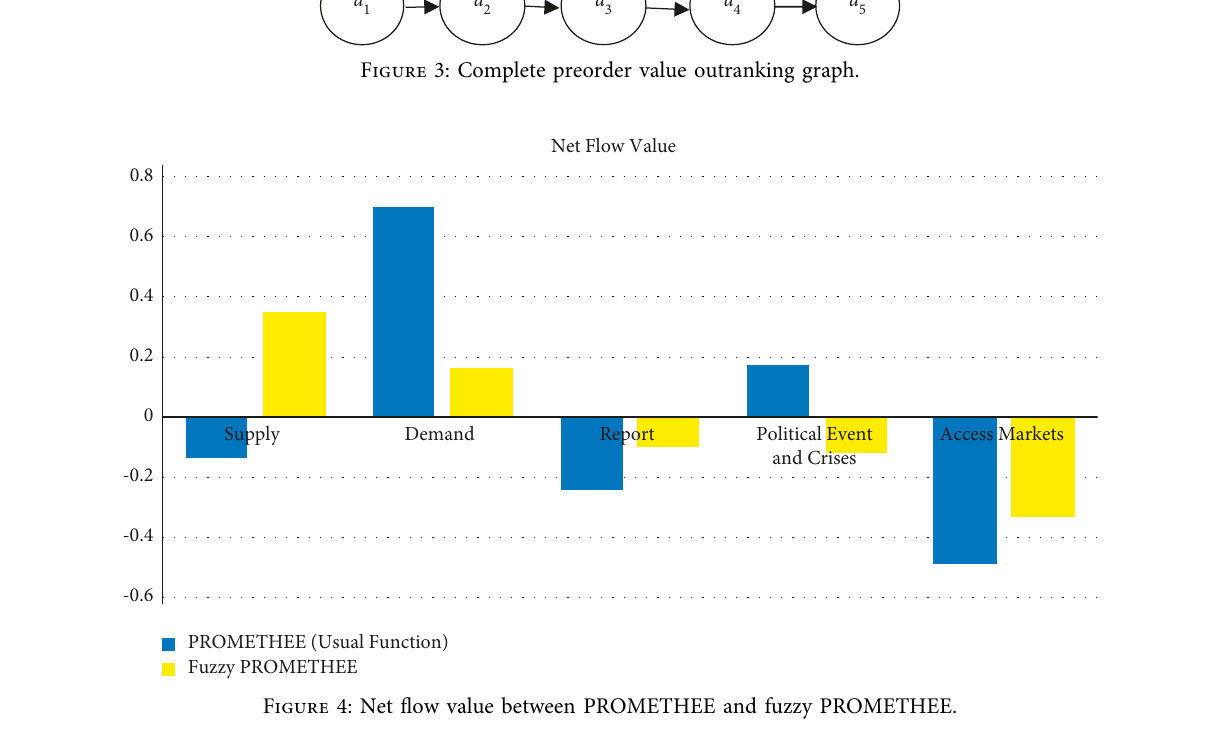
Figure 3: Complete preorder value outranking graph.